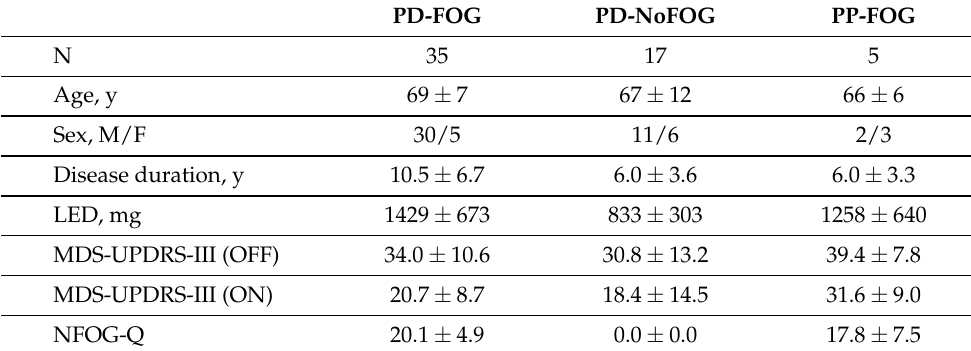
Table 1. Clinical and demographic features of study participants. PD-FOG PD-NoFOG